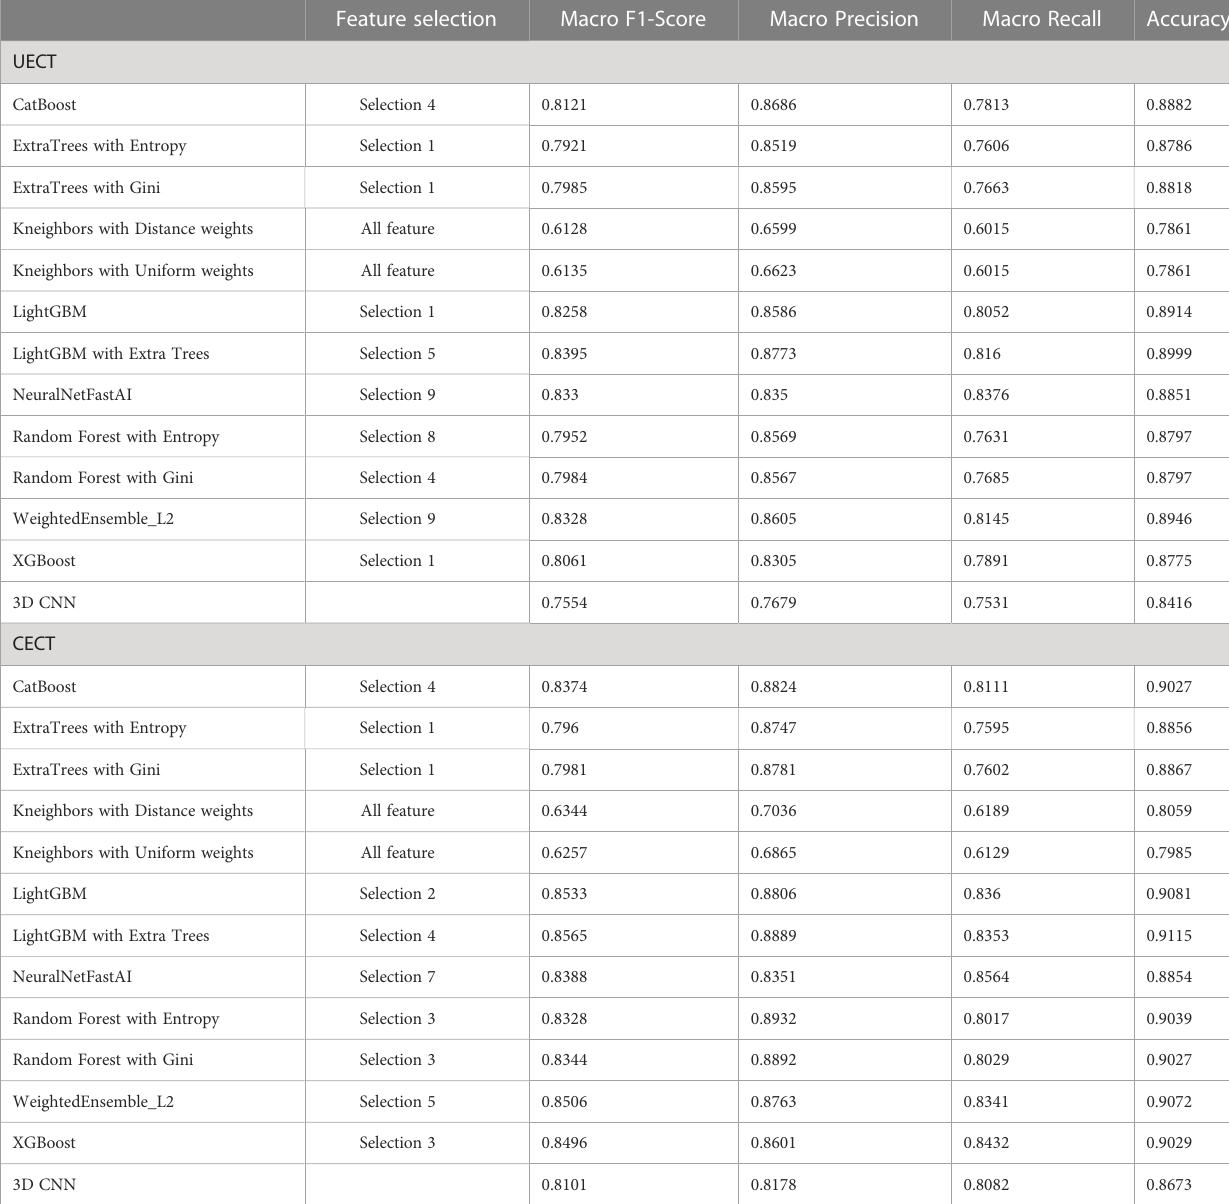
TABLE 4 The best result of radiomics models and 3D CNN model to differentiate thymoma from other prevascular mediastinal